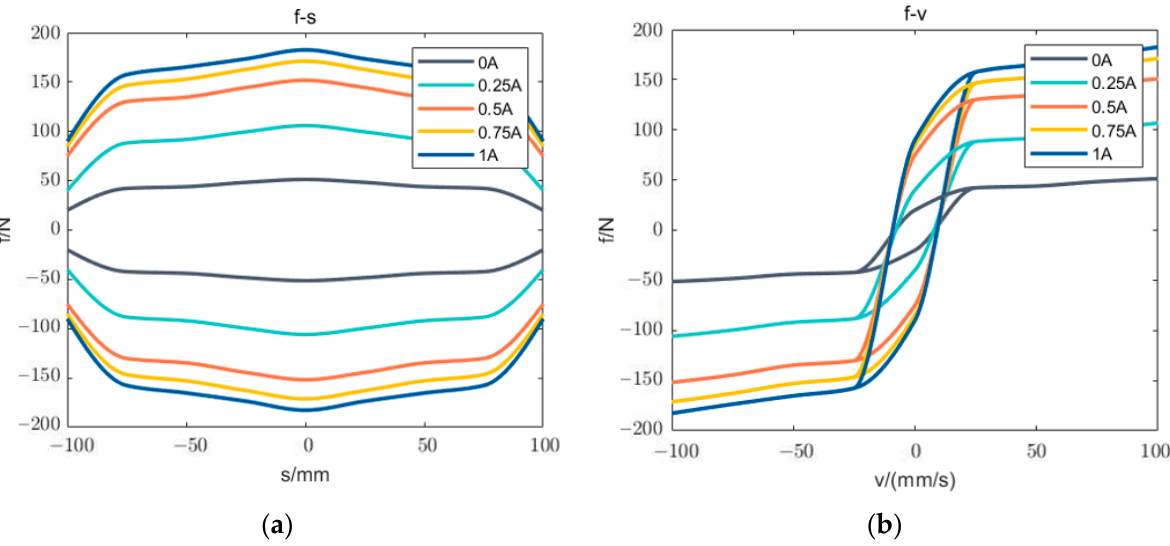
Figure 7. Magneto-rheological fluid absorber performance. ( a ) Magneto-rheological fluid absorber f-s curve; ( b ) Magneto-rheological fluid absorber f-v curve. where 𝑓 represents the damping force, 𝑠 represents the piston displacement, and 𝑣 represents the piston velocity. All values were obtained through testing.